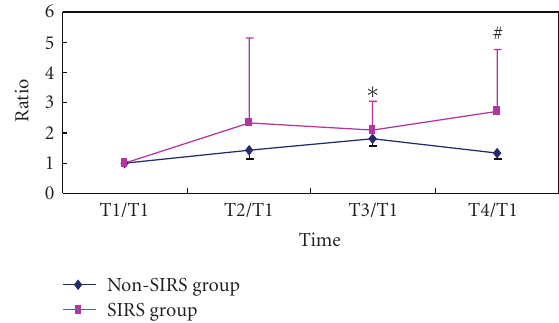
Figure 4: Upregulation of TLR4 expression on PBMC. Mean ± SD ( n = 12 for SIRS; n = 15 for non-SIRS); ∗ P < . 01, # P < . 05, compared with T1/T1.